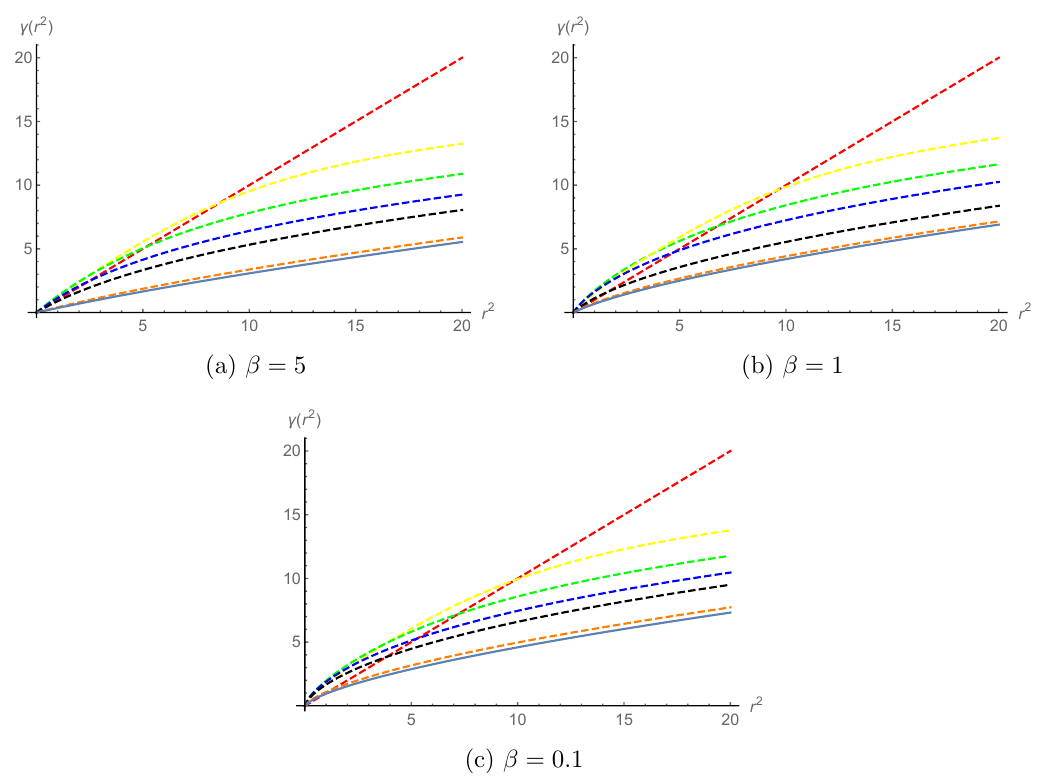
Figure 7. Convergence of the IR (cid:13)ow of (cid:13) (~ r 2 ) from the starting UV point (cid:13) = ~ r 2 (red dashed line) to the analytic IR solution (solid blue line). From top to bottom dashed lines (yellow to orange) represent the intermediate K(cid:127)ahler potentials from the early RG time to the late RG time.